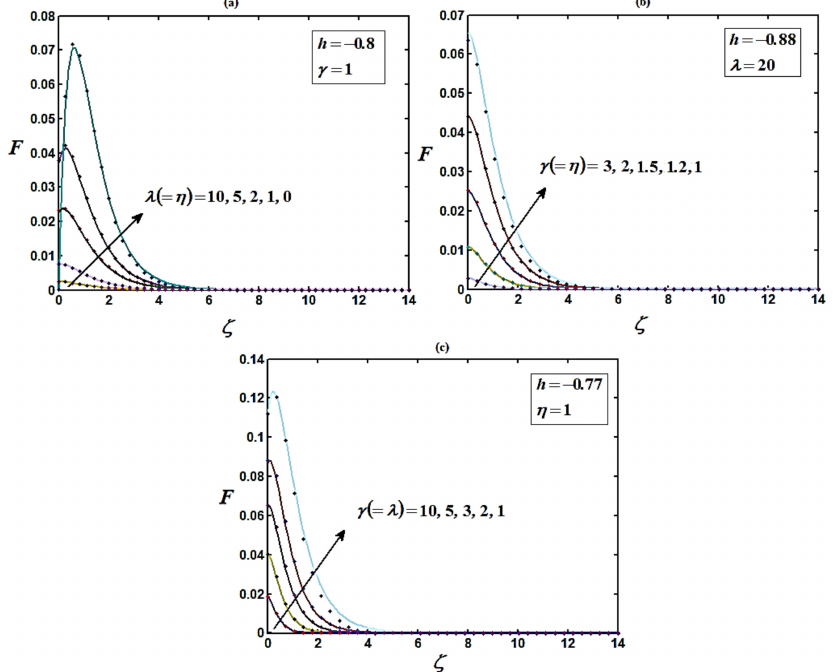
Figure 2. ( a – c ) Plots of the normalized radial velocity component F versus normalized distance from the disk ζ using Equation (13) for various values of parameters. Solid lines represent Equation (13) and dotted lines represent the numerical solutions